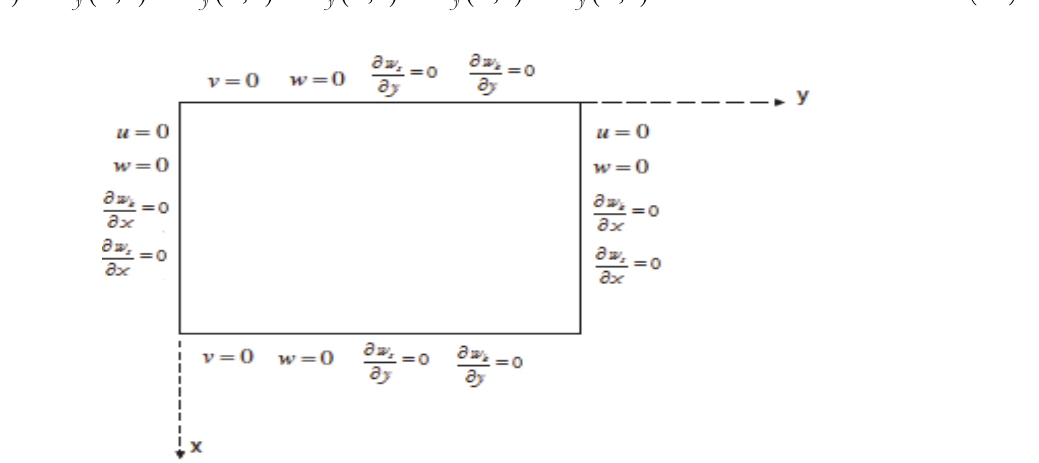
Figure 2: Boundary conditions for full